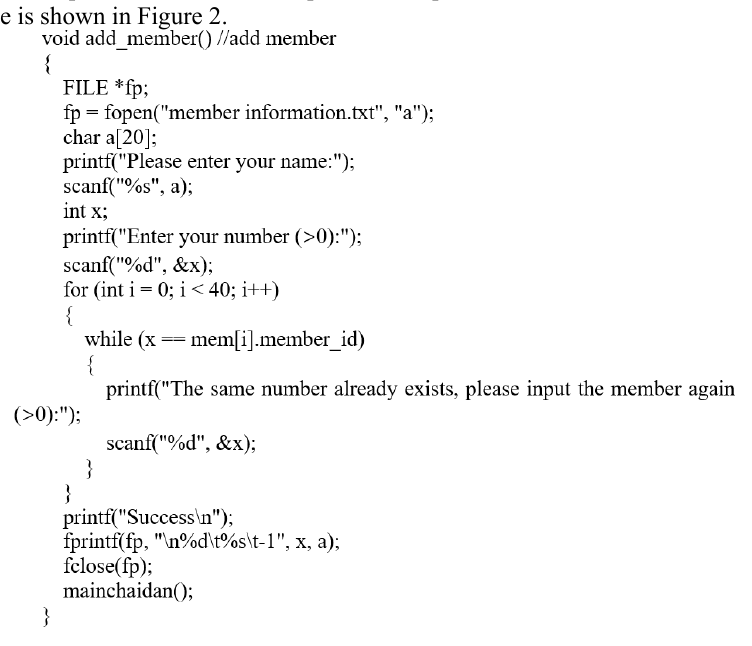
Fig. 2. A double loop in the membership management